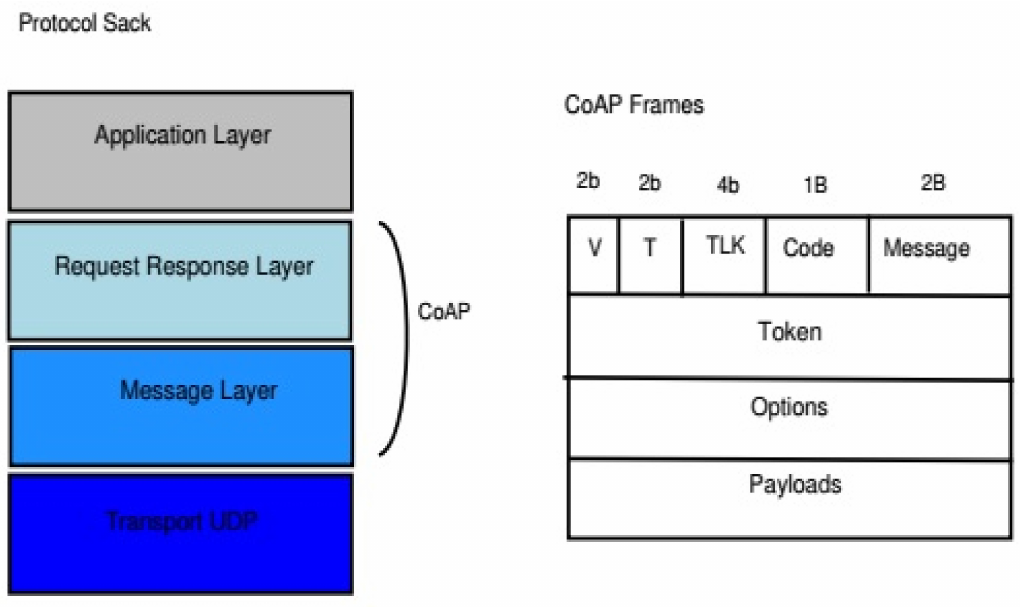
Figure 6. CoAP protocol